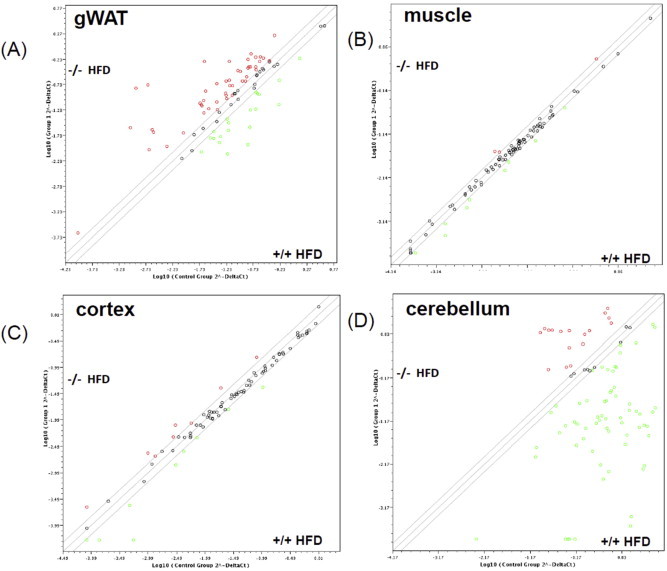
Scatter plot of the (A) epididymal white adipose tissue (gWAT); (B) muscle; (C) cortex or (D) cerebellum expression profile of 84 genes encoding components of the NFκB pathway. Each dot represents a gene and is obtained by plotting the log of the average normalised signal intensity of genes in the Fto−/− mice against the Fto+/+ mice on HFD state. Green dots represent genes that are down-regulated in Fto−/− mice and the red dots are those that are up-regulated in Fto−/− mice.